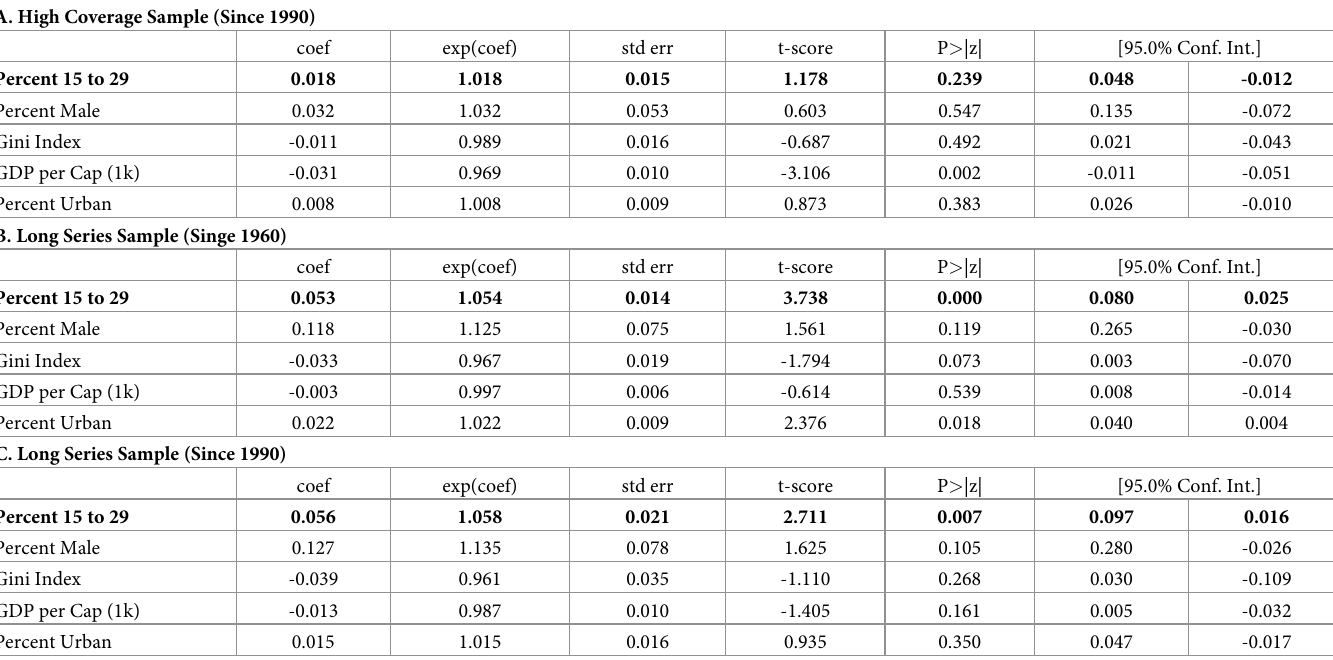
Table 1. Fixed effects models for the average effect of percent 15 to 29 on (ln) homicide rate. A. High Coverage Sample (Since